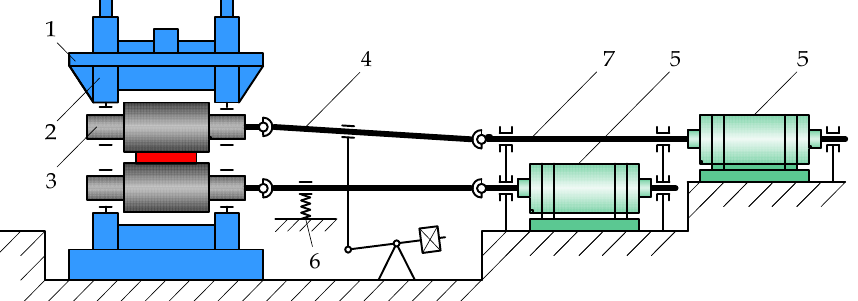
Figure 1. Working line scheme for the rolling mill’s main drive with independent roll drives: 1— roll stand; 2—housing; 3—working rolls; 4—universal spindles; 5—motors; 6—spindle balance; 7— countershaft.